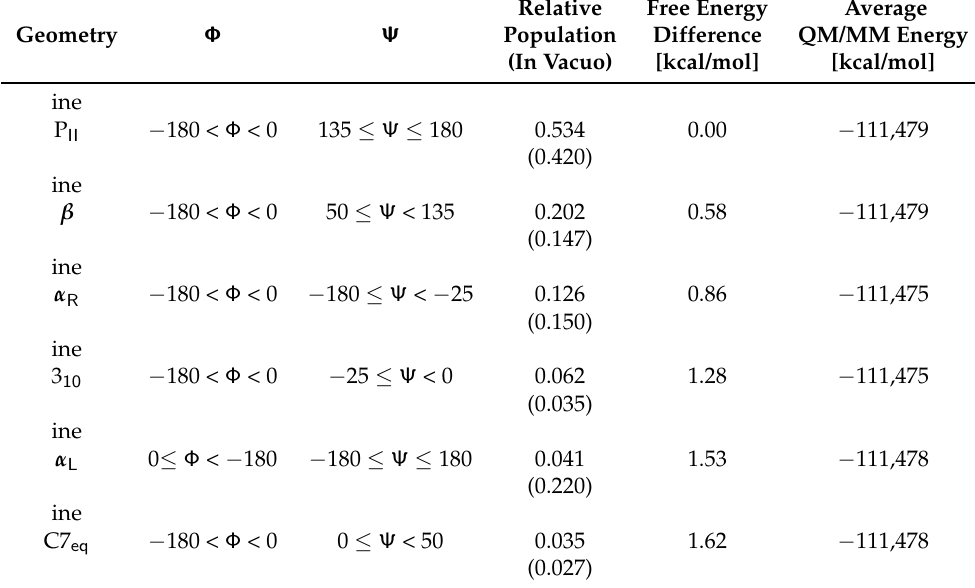
Table 1. The relative populations of XAO geometries from simulations in water are listed for six Φ - Ψ geometry basins in Ramachandran plot; populations obtained from simulations in vacuo are listed below in parentheses. Free energy differences [kcal/mol], obtained from a population analysis F = − k B T ln ( N b / N ref ) , between the six sampled geometries are listed. The last column lists average QM/MM energies [kcal/mol] calculated from snapshots of XAO and the ten nearest water molecules, extracted from the 900 ns MD simulation. The Φ - Ψ dihedral angles (given in degrees) correspond